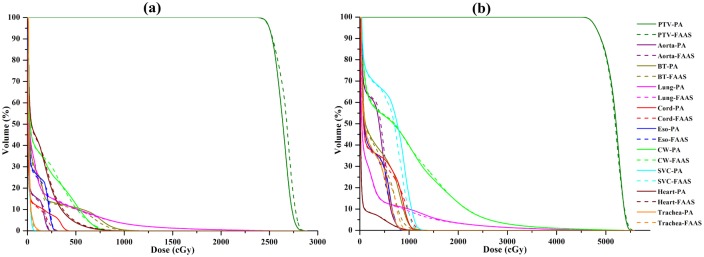
A representative DVH from the PA and FAAS plans in the two groups of patients.(a) small tumor group; (b) large tumor group. BT = bronchial tree; Eso = esophagus; CW = chest wall; SVC = superior vena cava.